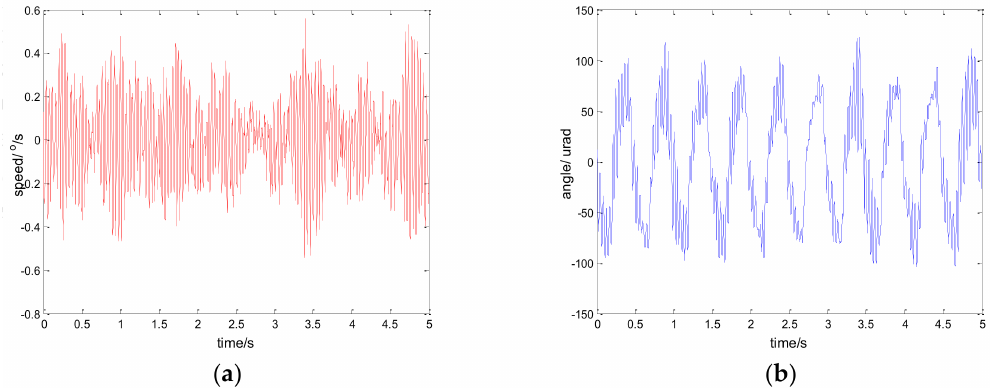
Figure 18. Experiment results of PI control. d = sin ( 2 π × 2 t ) : ( a ) speed; and ( b ) tracking error, RMS = 55.7748 urad.